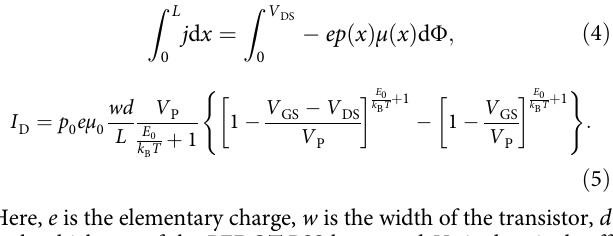
(9) only depends on the scaled position inside the transistor , counting the sections of the channel underneath channel x 0 ¼ x L the electrodes as well will not change conclusions drawn later. The applied gate voltage ranges from − 0.1 to 0.7 V and the drain voltage is varied from − 0.1 to − 0.5 V, so that the linear as well as the saturation region of the transistor is studied. Figure 2 plots (Fig. 2a). The remaining plots for V GS = 0.1 , 0.3, and 0.5 V are shown in Supplementary Fig. 3. At V GS = − 0.1 V, the